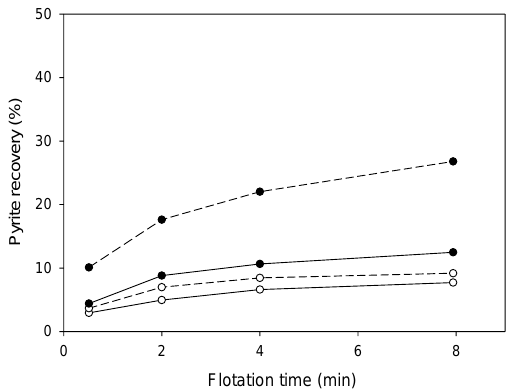
Figure 27. Pyrite mineral flotation as a function of time under oxidizing conditions: (o) no Cu 2+ ions; (●) with 1. 5 × 10 −3 M Cu 2+ ; (dotted lines) grinding balls in steel; (solid lines) 30 wt% of grinding balls with chromium (adapted from Peng et al. [121]).